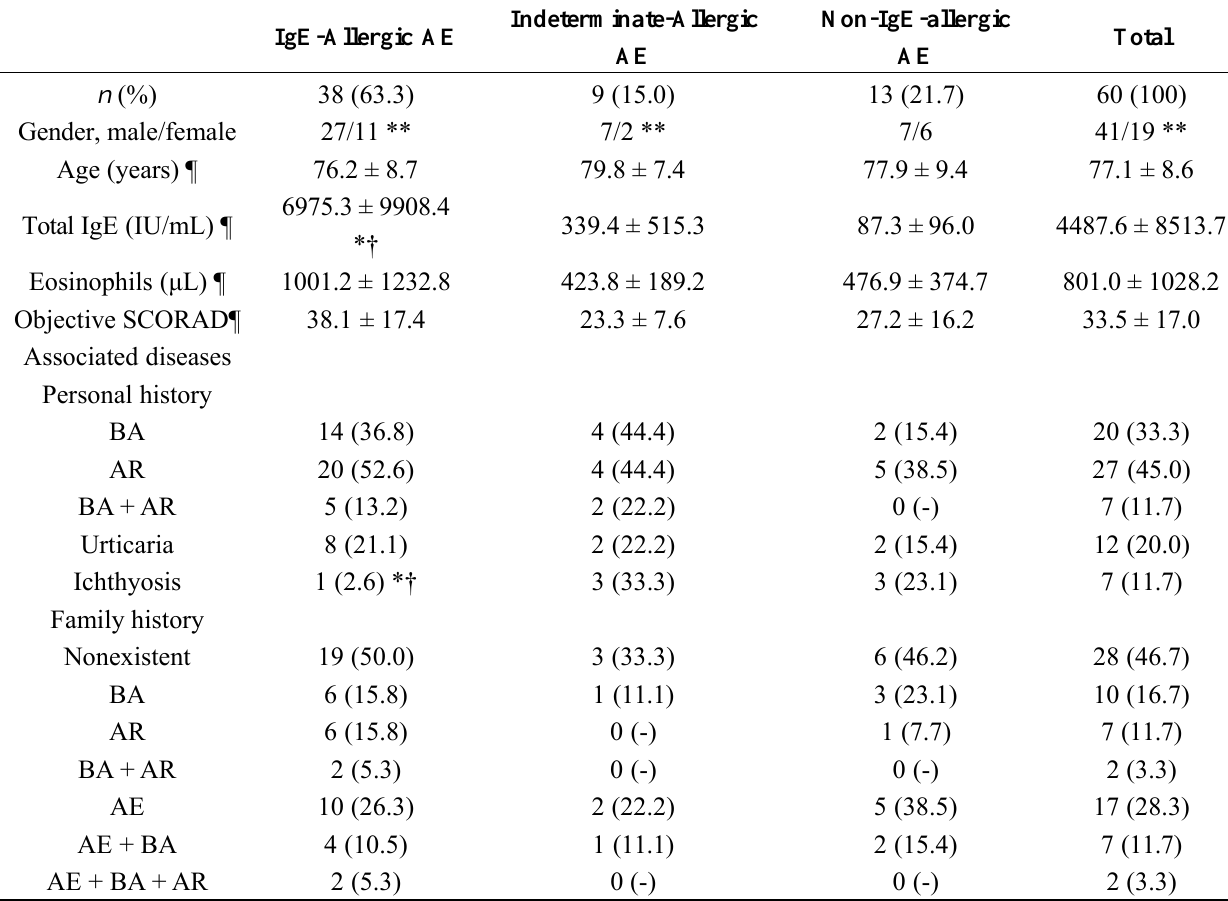
Table 1. Clinical and laboratory data of the 60 elderly patients with atopic eczema